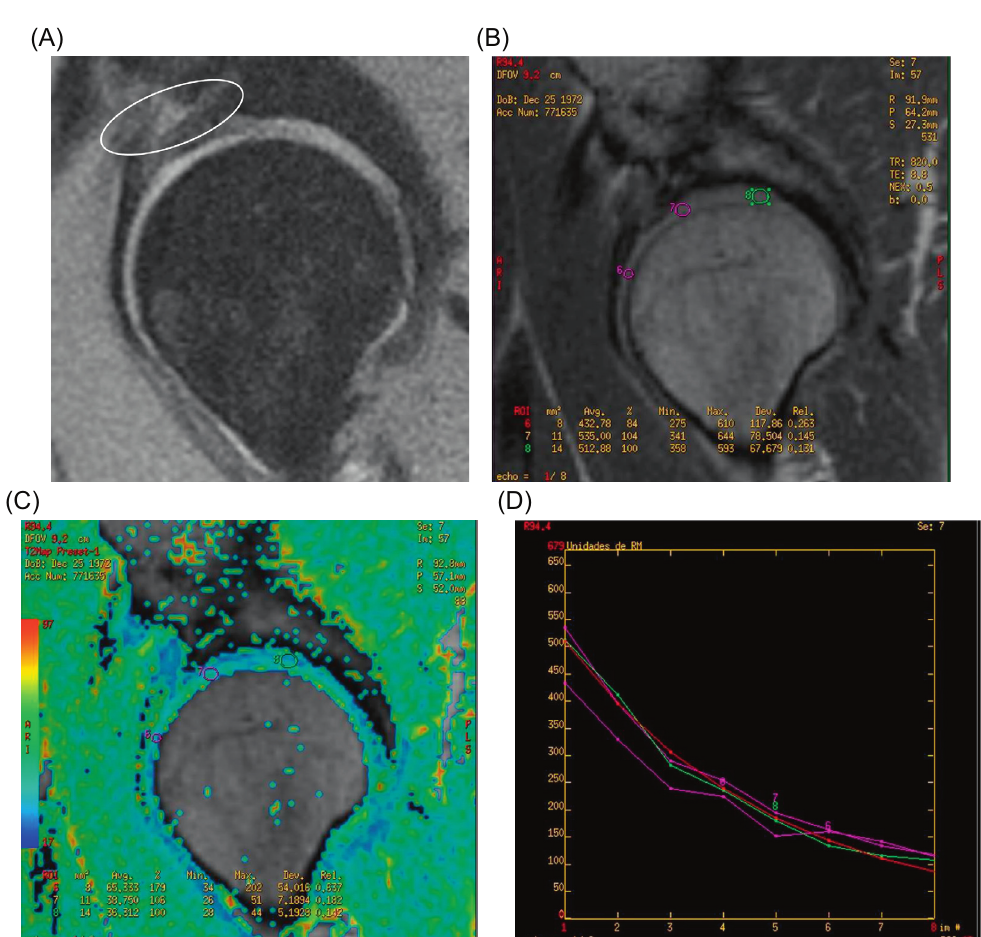
Figure 4. Pre- and post-operative MR of case number 2. The improvement is evaluated quantitative (100% of filling of the lesion) and qualitative (decrease in T2 values, showing hyaline cartilage). (A) PDFS sagital imaging of the right hip showing the extensive zone of alteration of the signal and delamination in the anterosuperior quadrant of the acetabular articular surface. (B–D) T2 mapping of the same joint 15 months after the surgery and the morphological improvement of the chondral lining and practical normalization of T2